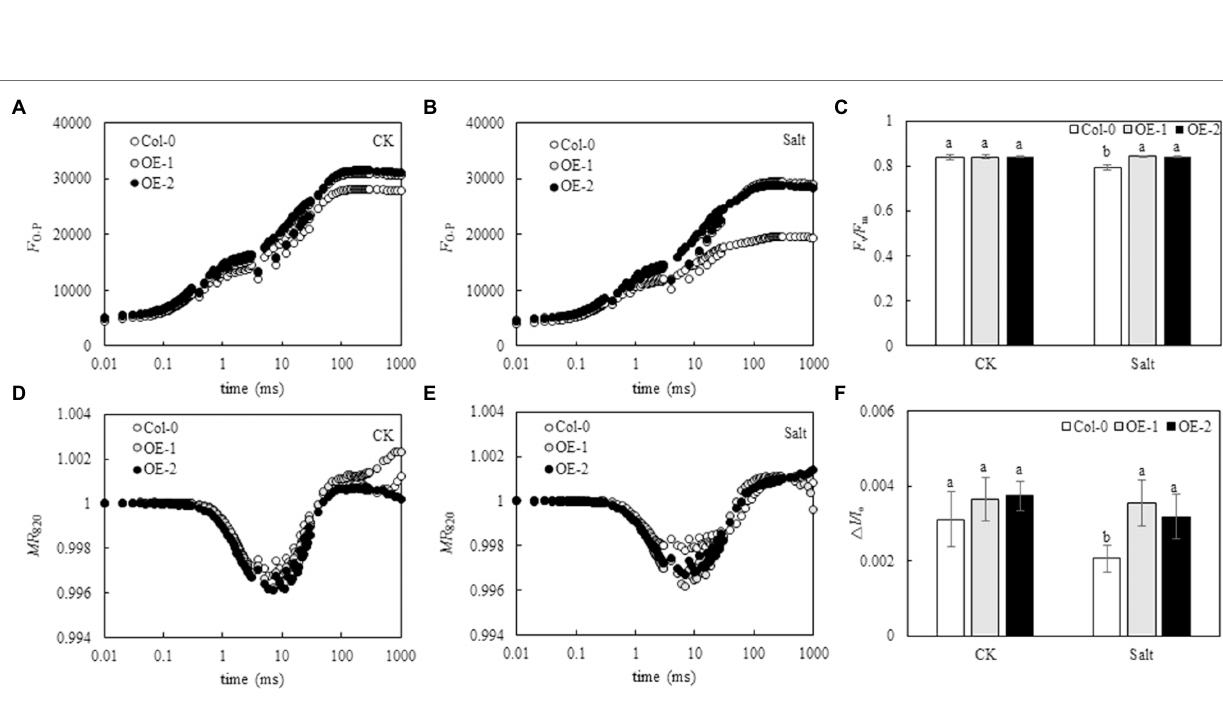
FIGURE 3 | Effects of MYB37 overexpression on Chl a content (A) , Chl b content (B) , Chl a + b content (C) , and Chl a / b ratio (D) in Arabidopsis leaves under NaCl stress. Data are expressed as means ± SE of three replicated experiments ( n = 3). Different small letters indicate significant differences ( p < 0.05).